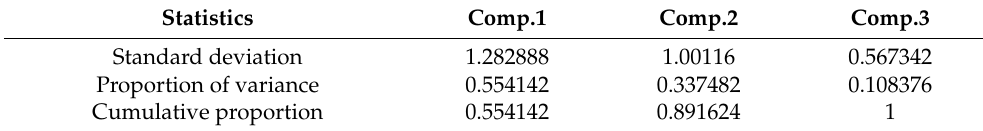
Table 9. The value of the dispersion of the principal components of the projection CI, D1, Datt3 Ambrosia artemisiifolia , Atriplex tatarica , Glycyrrhiza glabra , Euphorbia seguieriana , and Setaria pumila .